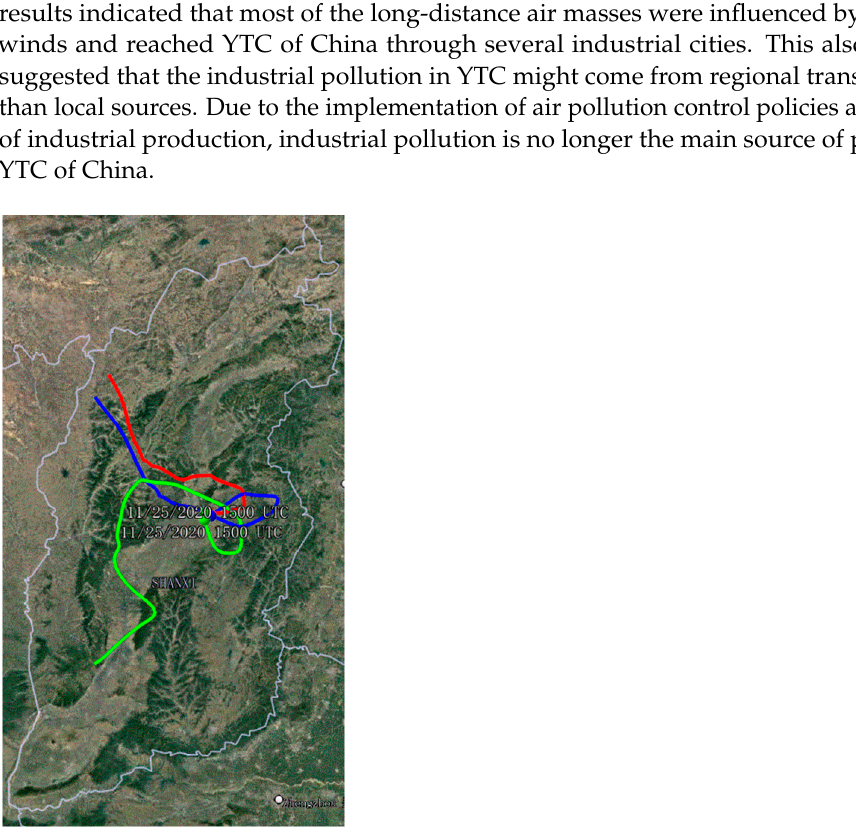
Figure 4. The 72-h back trajectories on 25 November 2020 in Yuci College Town, Shanxi, China. The red color line represents the height of 50 m; blue line: 500 m; green line: 1000 m.